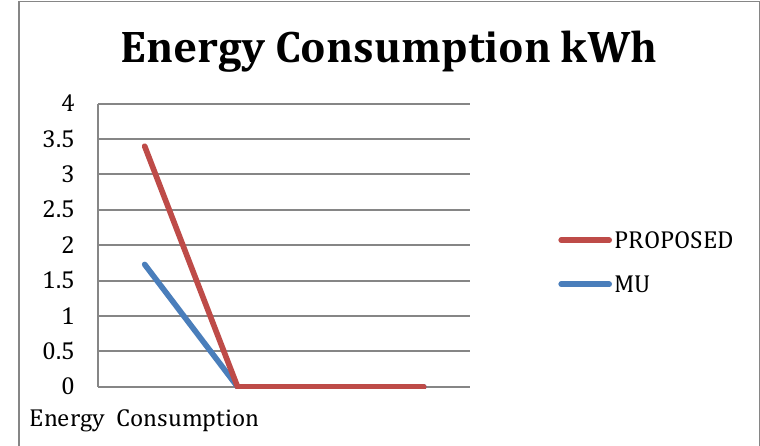
Fig. 2. Energy consumption for MU and proposed